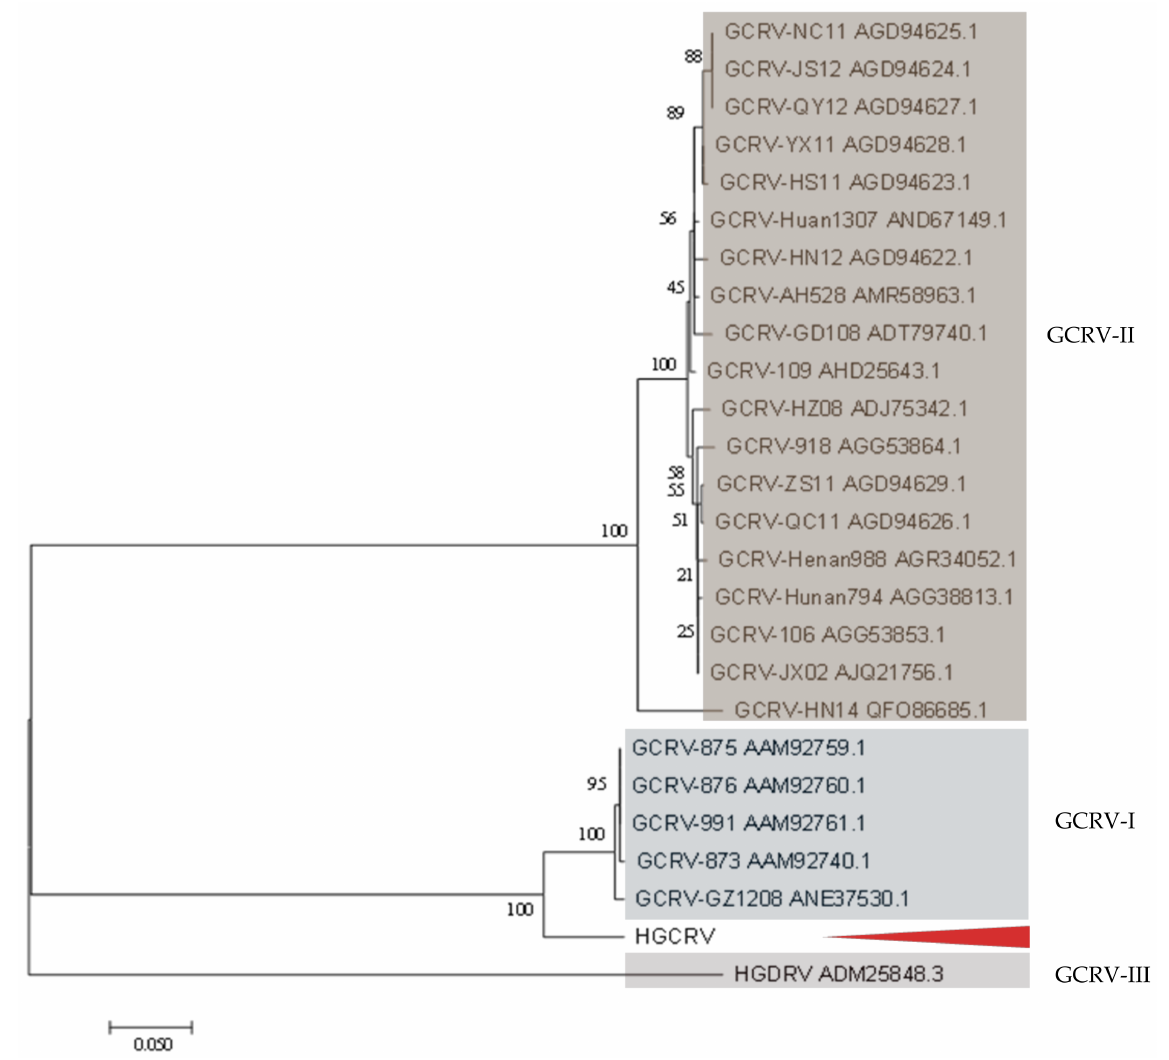
Figure 6. Phylogenetic analysis of HGCRV and other grass carp reovirus strains based on their VP6 (core protein) protein sequences. The analysis involved 26 amino acid sequences, and HGCRV is indicated with an arrow. The phylogenetic tree was constructed using the neighbor-joining method using 500 bootstrap replicates. The scale bar indicates the evolutionary distance (the average number of amino acid substitutions per site). HGCRV, healthy grass carp